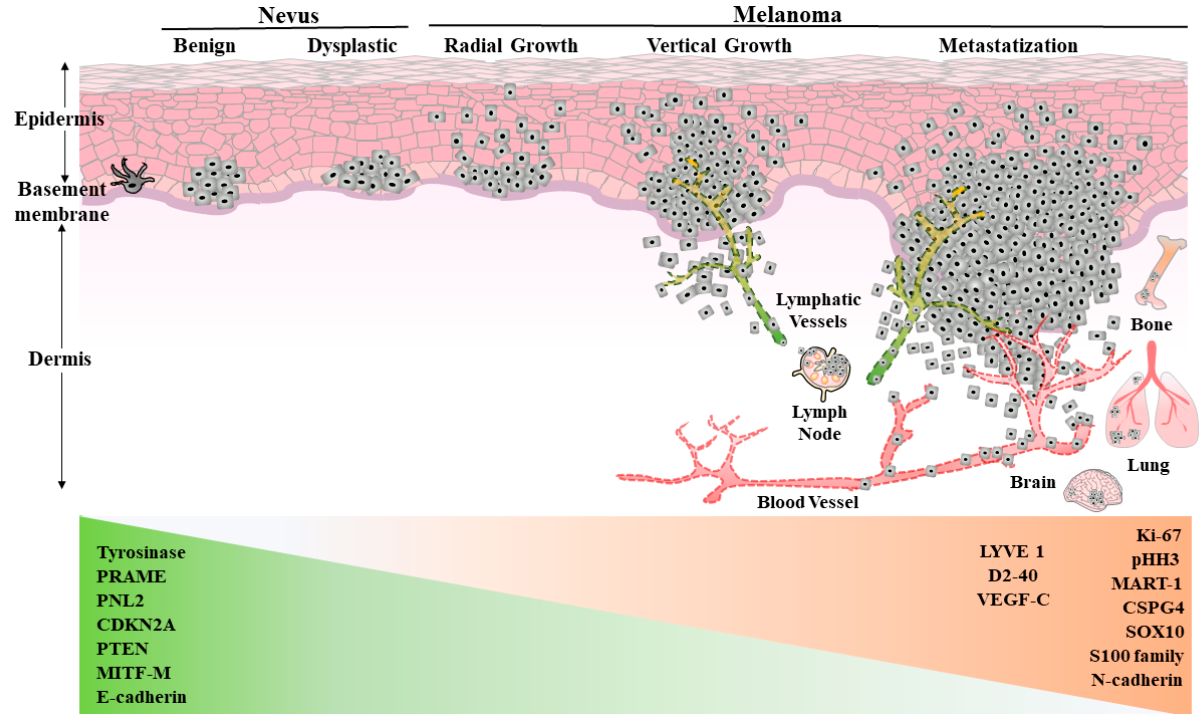
Figure 1. Schematic picture of melanoma progression from benign nevus to metastatic stage. Representative melanocytic associated and lymphangiogenic specific immunohistochemical markers are reported. PRAME: preferential expressed antigen in melanoma, CDKN2A: cyclin dependent kinase inhibitor 2A, PTEN: phosphatase and tensin homolog, MITF-M: microphthalmia transcription factor protein M, LYVE-1: lymphatic vessel endothelial hyaluronan receptor 1, D2-40: podoplanin antibody, VEGF-C: vascular endothelial growth factors C, pHH3: phospho-Histone H3, MART-1: melanoma antigen recognized by T cells 1, CSPG4: chondroitin sulfate proteoglycan 4, SOX10: SRY-related HMG-box transcription factor 10.